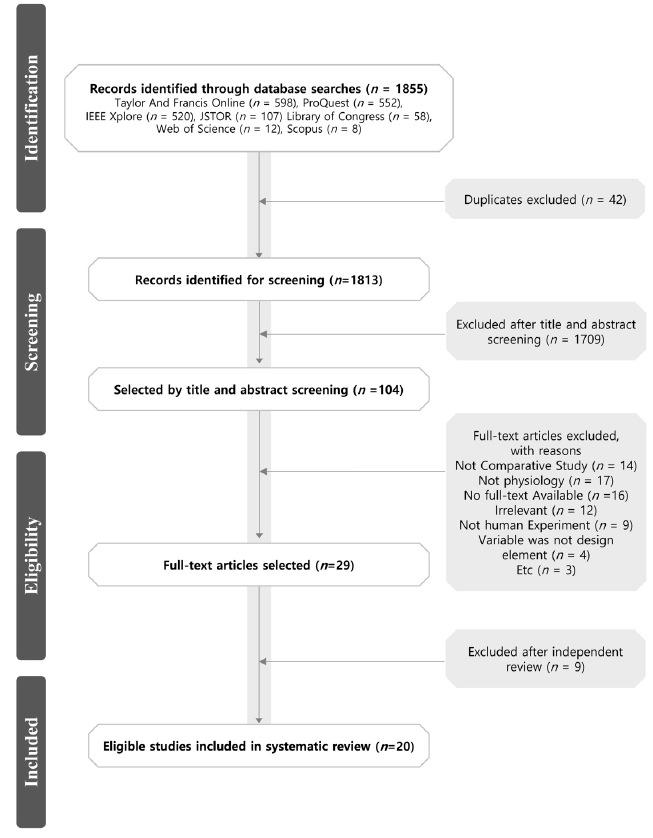
Figure 1. Diagram of the systematic review and meta-analysis workflow.